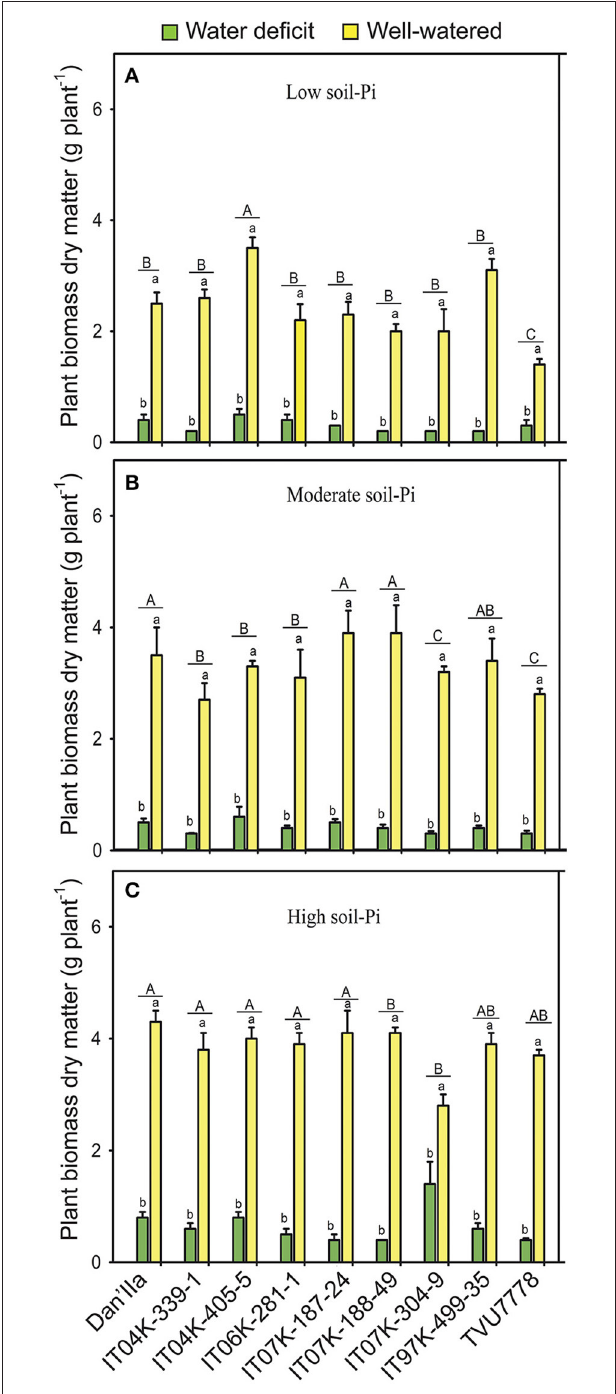
FIGURE 1 | Plant biomass dry matters of cowpea varieties under different available soil-phosphate (Pi) levels with or without water deficit stress. (A) Low soil-Pi, (B) moderate soil-Pi, and (C) high soil-Pi. Mean values and standard errors (bars) are shown ( n = 4). Different small letters indicate significant differences between the water-deficit and well-watered plants for each variety at each available soil-Pi level (Fisher’s test; p < 0.05). Different capital letters indicate significant differences among the varieties at each available soil-Pi level (Fisher’s test; p <